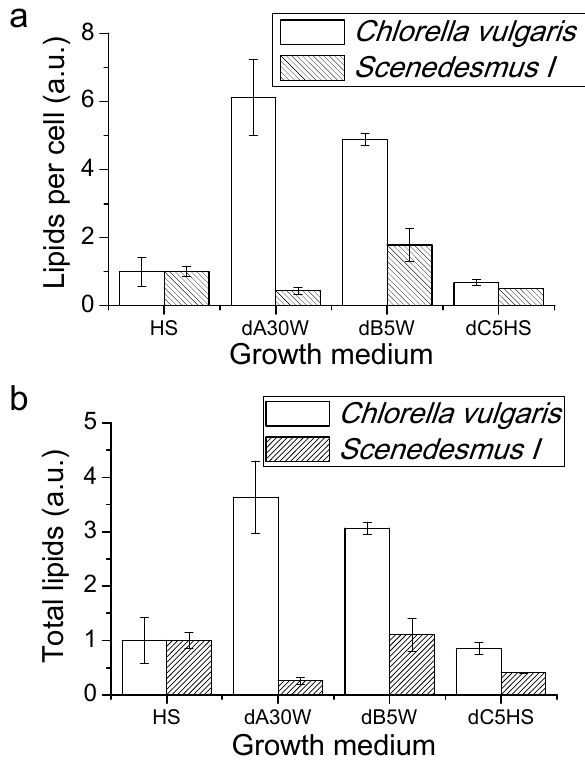
Figure 5. Nile red assay for lipid quantification in microalgae cultures: ( a ) Nile red fluorescence emission normalized per cell content indicating the lipid content per cell; and ( b ) total lipids accumulated on microalgae cultures expressed as Nile red fluorescence emitted by the same volume of culture in the different conditions. The values reported were normalized to the case of cells grown in HS medium and expressed as arbitrary units (a.u.).